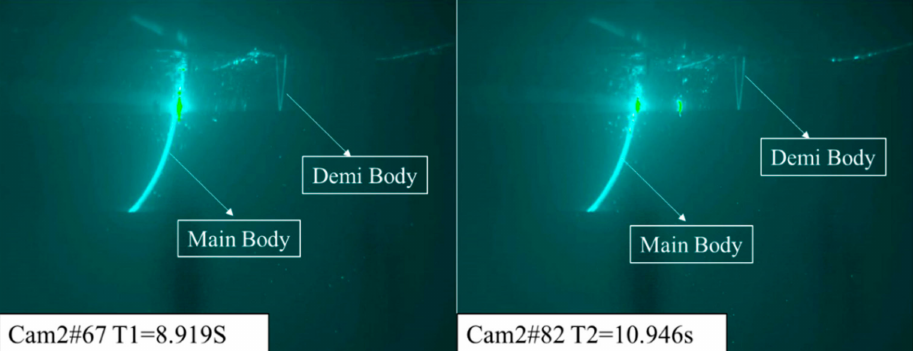
Figure 15. Images #67 and #82 captured by Cam2 at x / Lpp = −